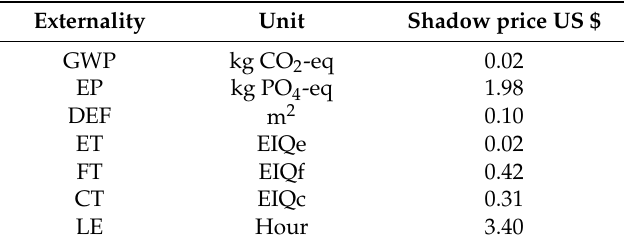
Table 4. Shadow prices of externalities in rice production.